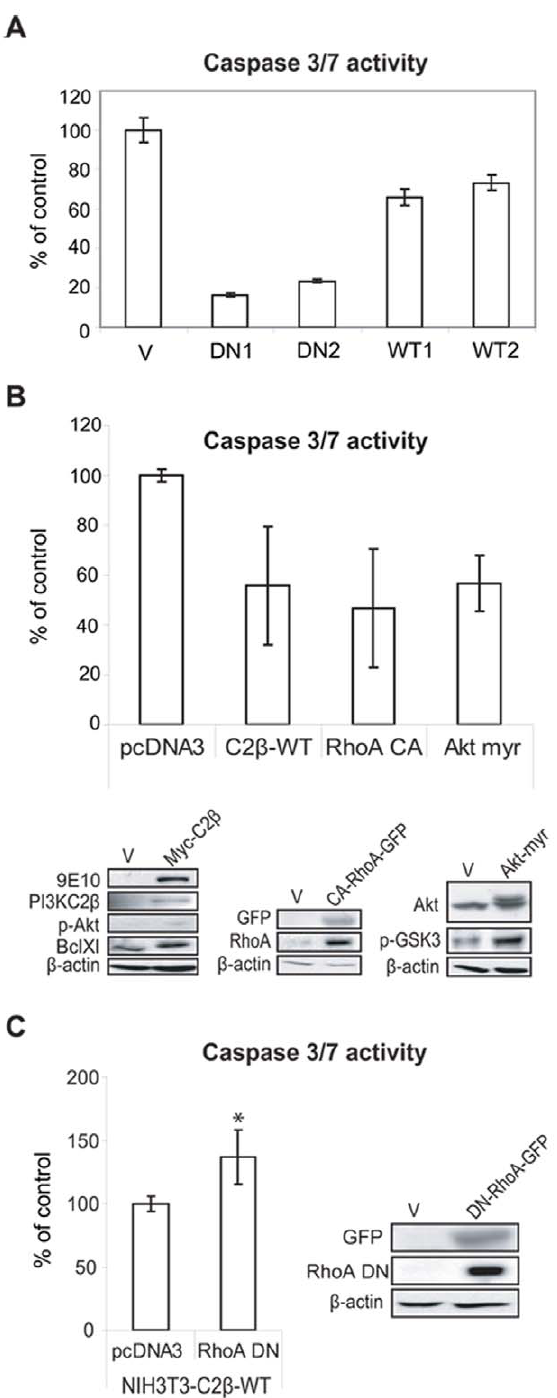
Figure 7. PI3KC2 b increases MAPK and Akt signalling down- stream of EGFR and PDGFR. (A) and (B) NIH3T3-V, -C2 b -DN and - C2 b -WT cells were serum-deprived overnight and stimulated for 10 min. with EGF (A) or PDGF (B) as indicated. Cell lysates were analysed by immunobloting and MAPK and Akt pathway activation was assessed with indicated phospho-specific antibodies. (C) and (D) Lysates of NIH3T3-V, -C2 b -DN and -C2 b -WT cells grown in 10% FCS were analysed for activated signalling molecules implicated in the cell